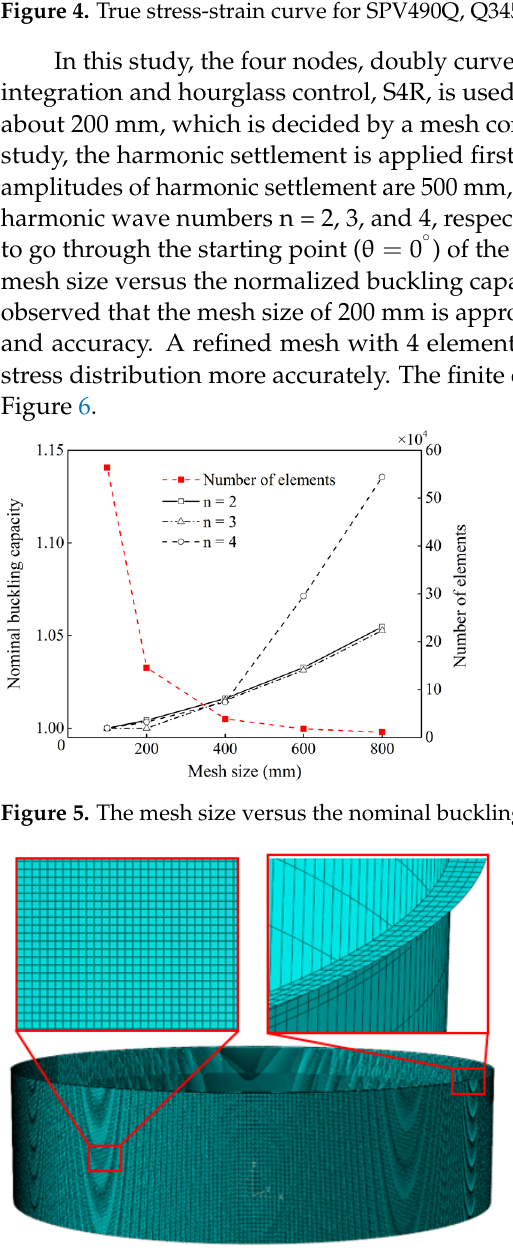
Figure 5. The mesh size versus the nominal buckling capacity and the number of elements. Figure 6. Finite element mesh for the steel tank with angle Figure 6. Finite element mesh for the steel tank with angle iron.